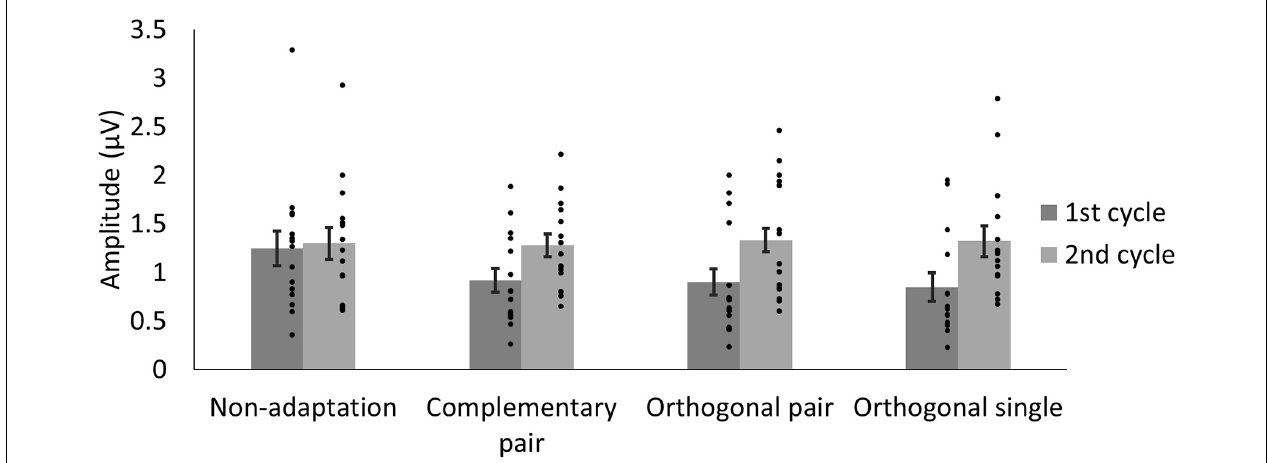
FIGURE 6 | Average amplitudes of the first and second 6 Hz cycles, modeled from the sum of the 3 Hz and 6 Hz signal data for each condition. The lower amplitude of the first cycles in the adaptation conditions may reflect responses driven by faces more similar to the adaptation images. Dots show amplitudes for individual participants. Error bars indicate SEM.